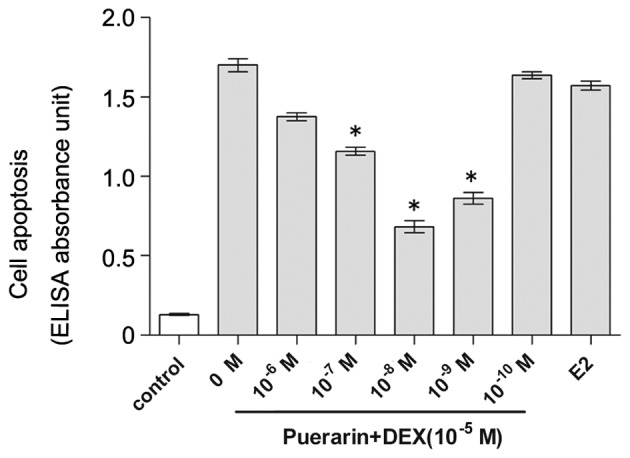
Purearin alleviates DEX-induced hFOB1.19 cell apoptosis. Cell apoptosis was measured using an enzyme-linked immunosorbent assay kit following pretreatment of the cells with 0 M and 10−6–10−10 M puerarin for 3 h. The cells were then incubated with DEX (10−5 M) for 48 h. Treatment with 10−8 and 10−9 M puerarin significantly reduced cell apoptosis. Data are presented as the mean ± standard deviation. *P<0.05, vs. DEX. DEX, dexamethasone.